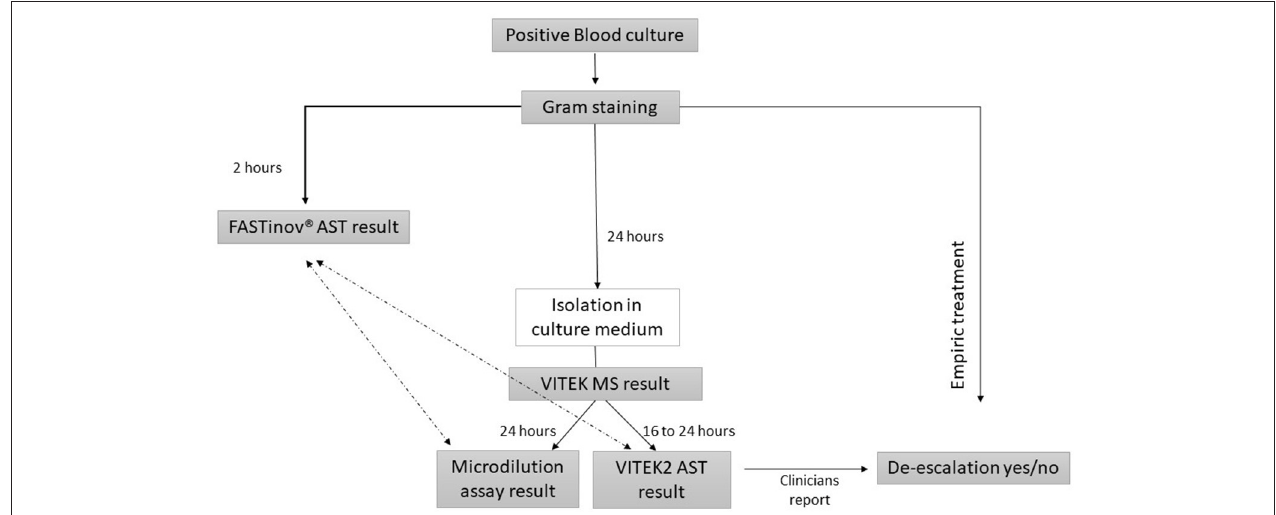
FIGURE 1 | Flowchart representing the overall study design. Only VITEK2 AST (BioMérieux) result was provided to clinicians. The stewardship team involved in the study evaluated the potential impact of FASTinov ® kit (around 23h earlier) on the clinical management of Gram-negative bacteremia. The FASTinov ® AST result was compared with VITEK2 and the gold standard microdilution assay (